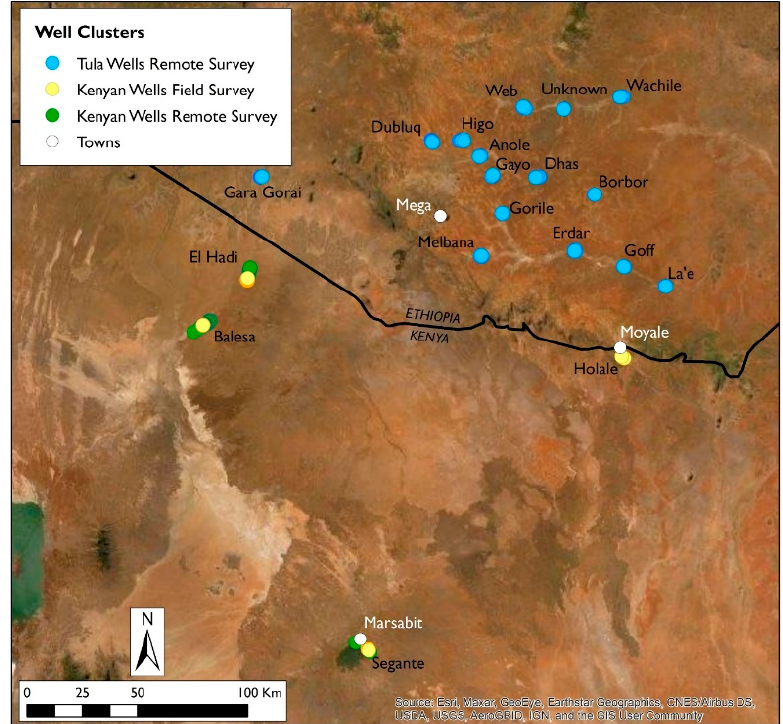
Figure 4. Distribution of well clusters in the area of interest.